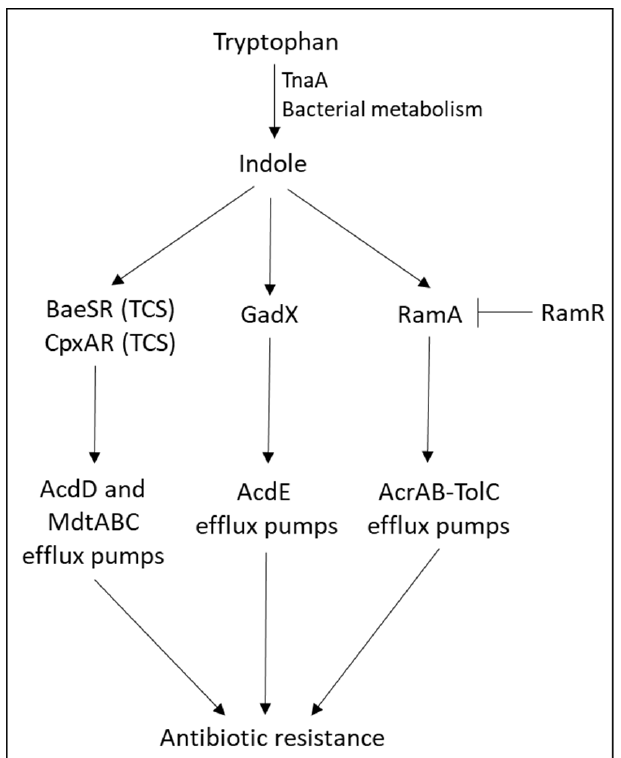
Figure 4. Induction of antibiotic resistance by the tryptophan metabolite indole. Indole, which is produced by various gut bacteria including Escherichia coli , induces the expression of various efflux pumps (e.g., AcdD, MdtABC, AcdE, AcrAB-TolC) through activation of TCSs (e.g., BaeSR, CpxAR) or transcriptional regulators (GadX, RamA). The activity of RamA is negatively regulated by RamR.